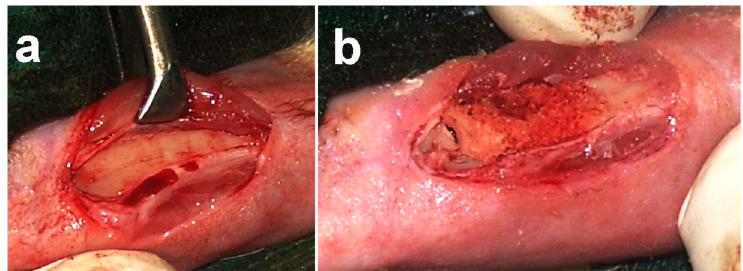
Figure 1. (a) Subcutaneous tissue and periosteum separated gently from cortical bone, and (b) The immediate hemostasis observed at the defect site after application of n-HA/gel/CMC scaffold construct, could helped in the formation of fibrin rich platform which thus, initiated spontaneous healing.